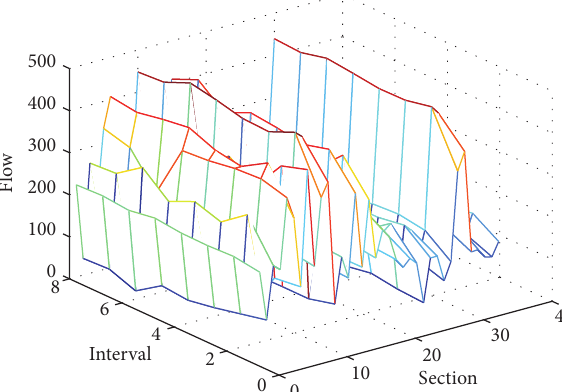
Figure 8: Averaged speed before optimization.